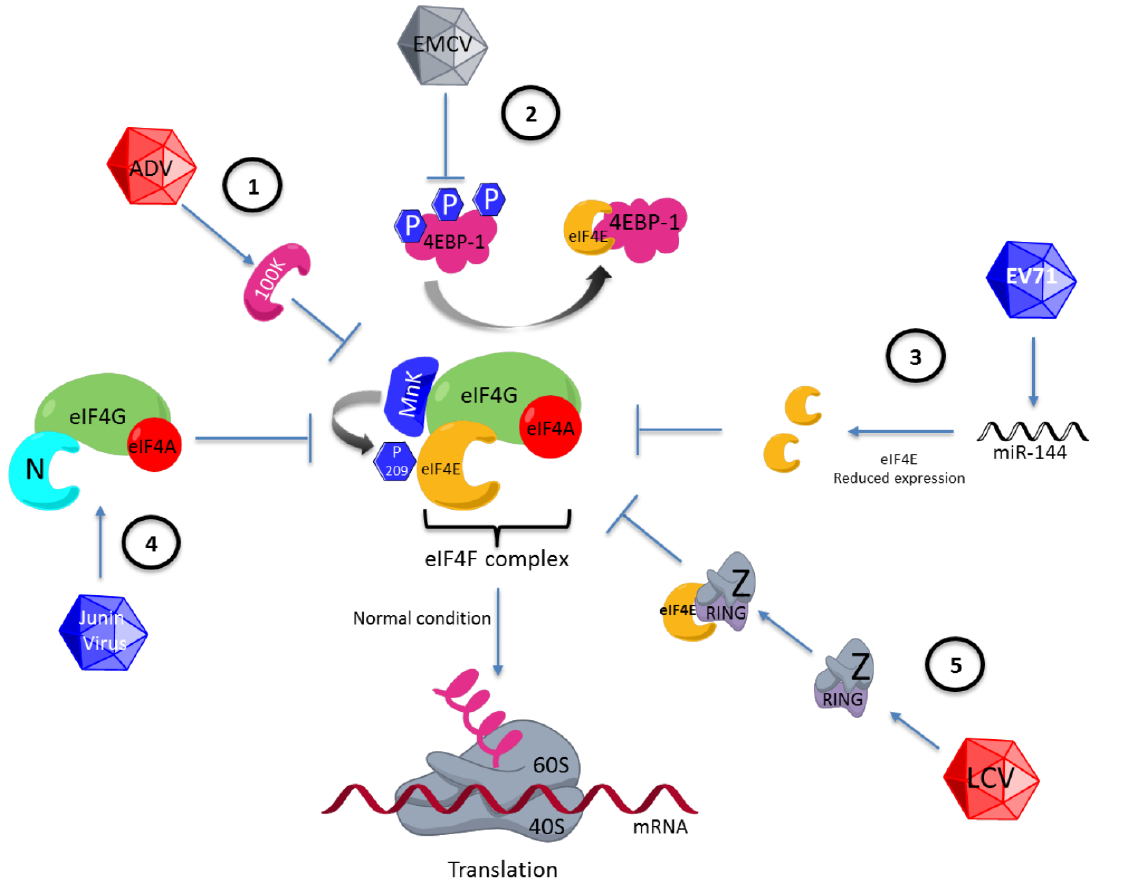
Figure 2. Differential regulation of eIF4F by various viruses. (1) eIF4E regulation via phosphorylation at serine 209. eIF4E is regulated by dephosphorylation by blocking of MnK1 by 100K adenovirus viral protein. (2) Regulation on 4EBP1. 4EBP1 is dephospohorylated during the encephalomyocarditis virus (EMCV) infection and eIF4E is hijacking the by 4EBP1 protein. (3) Alteration in eIF4E expression. Enterovirus 71 (EV71)